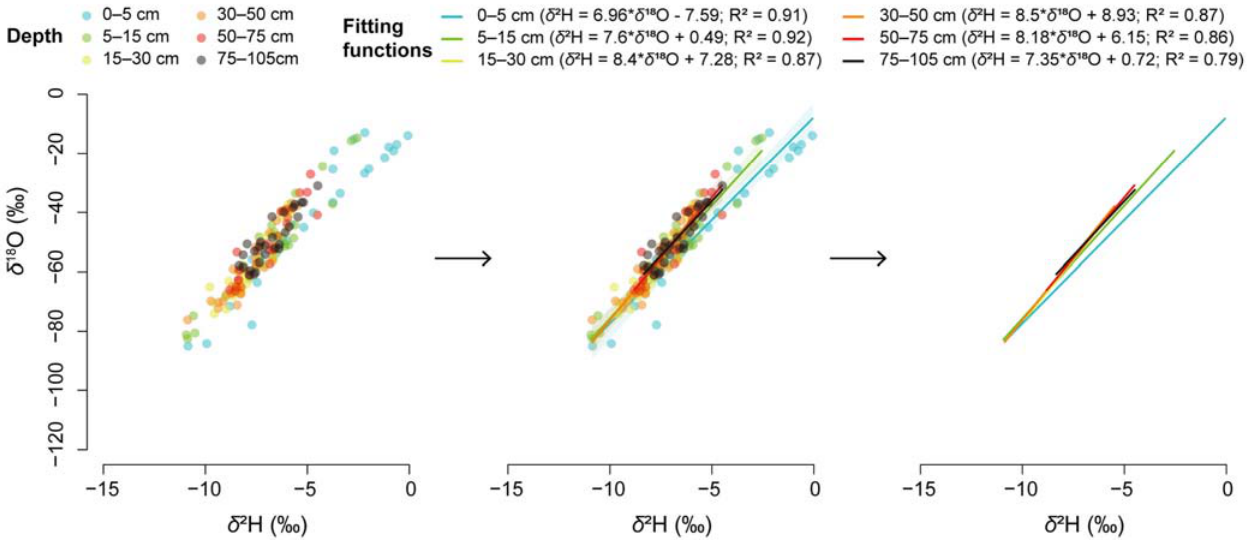
Figure 3. Dual-isotope plots of soil water in different soil layers. Soil water samples from different soil layers are shown as dots of different colors in the dual-isotope plot. The fitted lines indicate the soil evaporation lines of different soil layers.